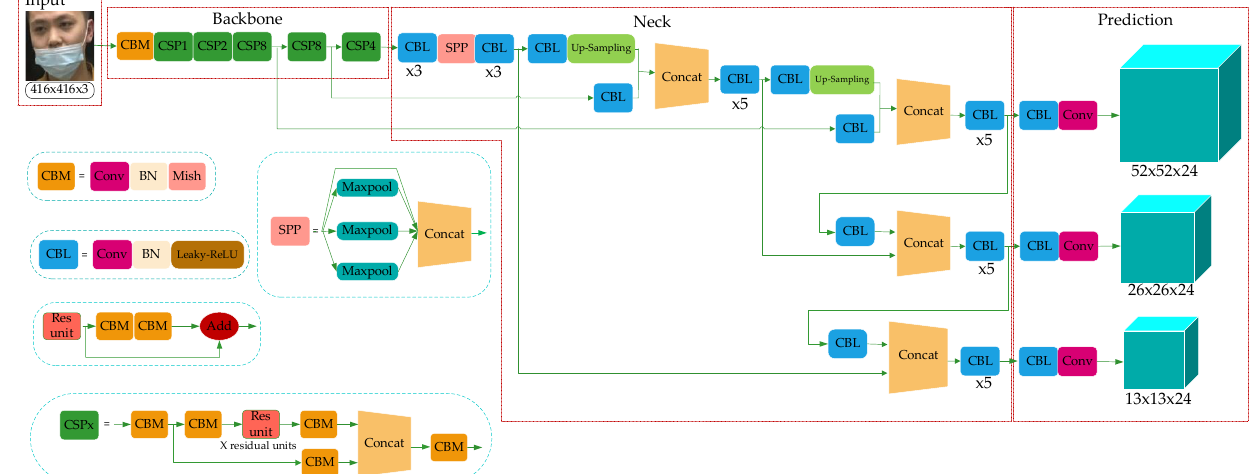
Figure 2. YOLO-v4 network structure.